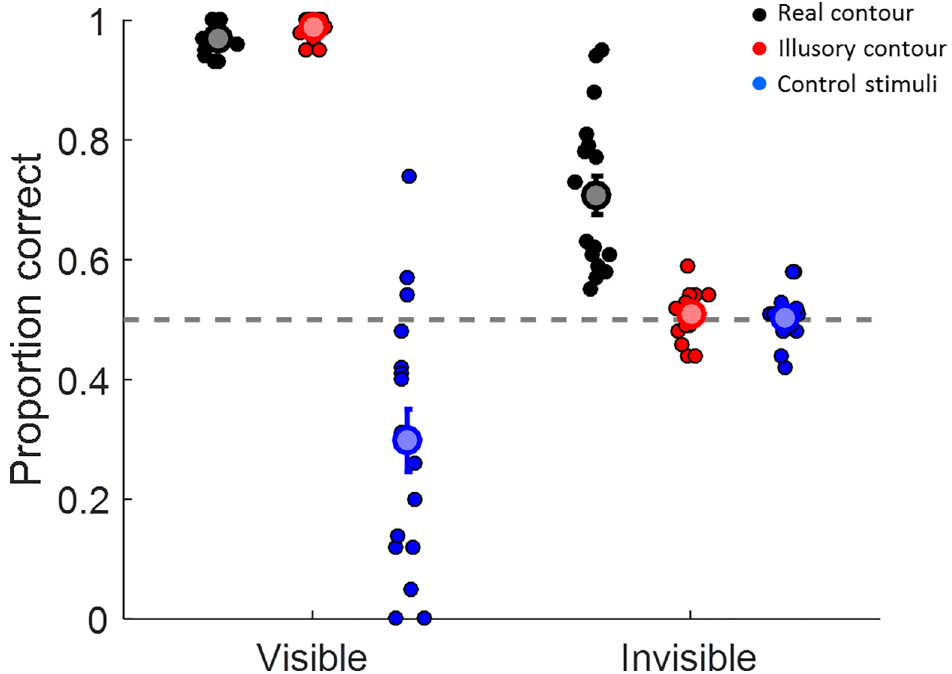
Fig 4. Results of experiment 1. Accuracy for discriminating the orientation of a triangle stimulus in visible or invisible (masked) trials. Each dot represents the performance of an individual participant in each of the conditions. The large symbols and error bars denote the mean ± 1 standard error for each condition. Black: real luminance contour. Red: illusory (Kanizsa) contour. Blue: control stimuli.